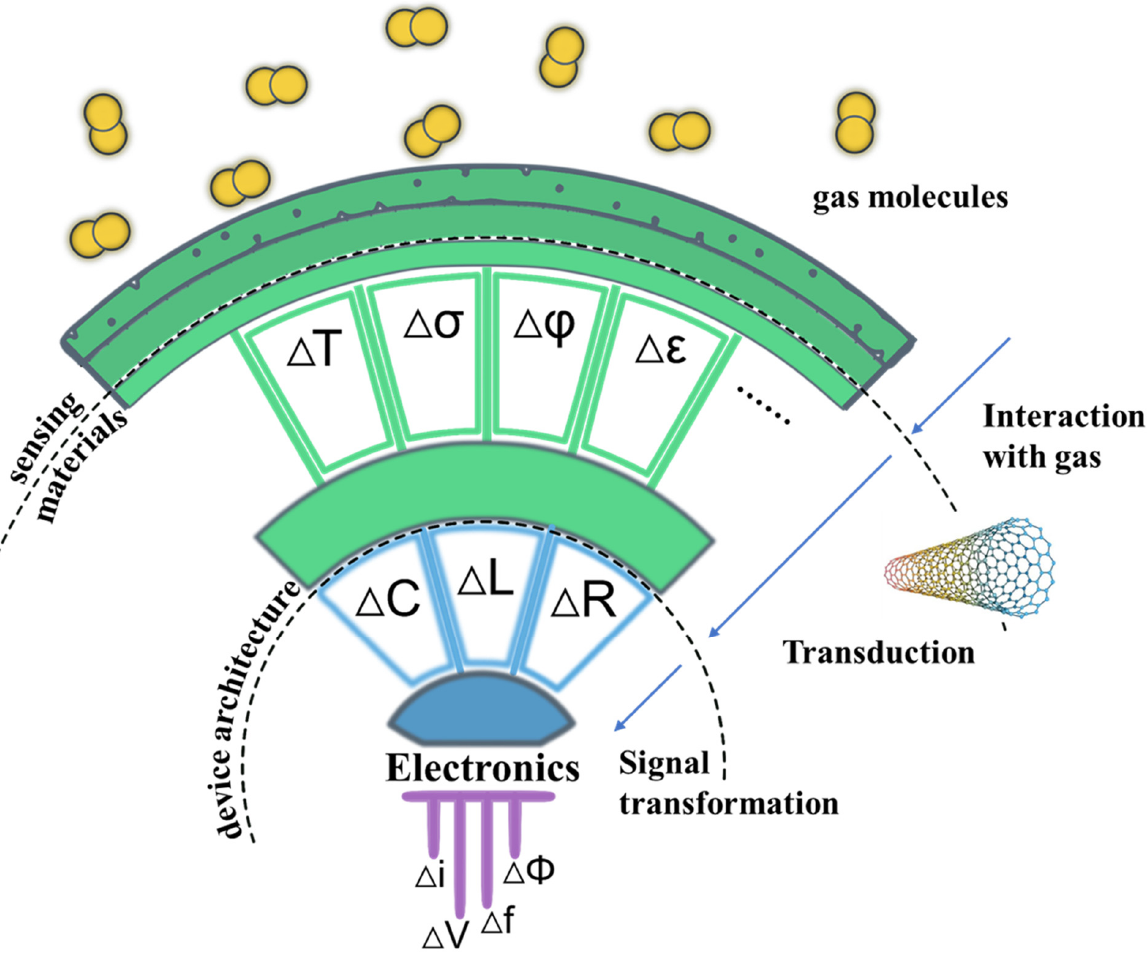
Figure 2. Logical structure of a gas sensor. Adapted with permission from American Chemical Society https://doi.org/10.1021/acs.chemrev.6b00361 (accessed on 4 August 2022) [28] . Analytes inter-